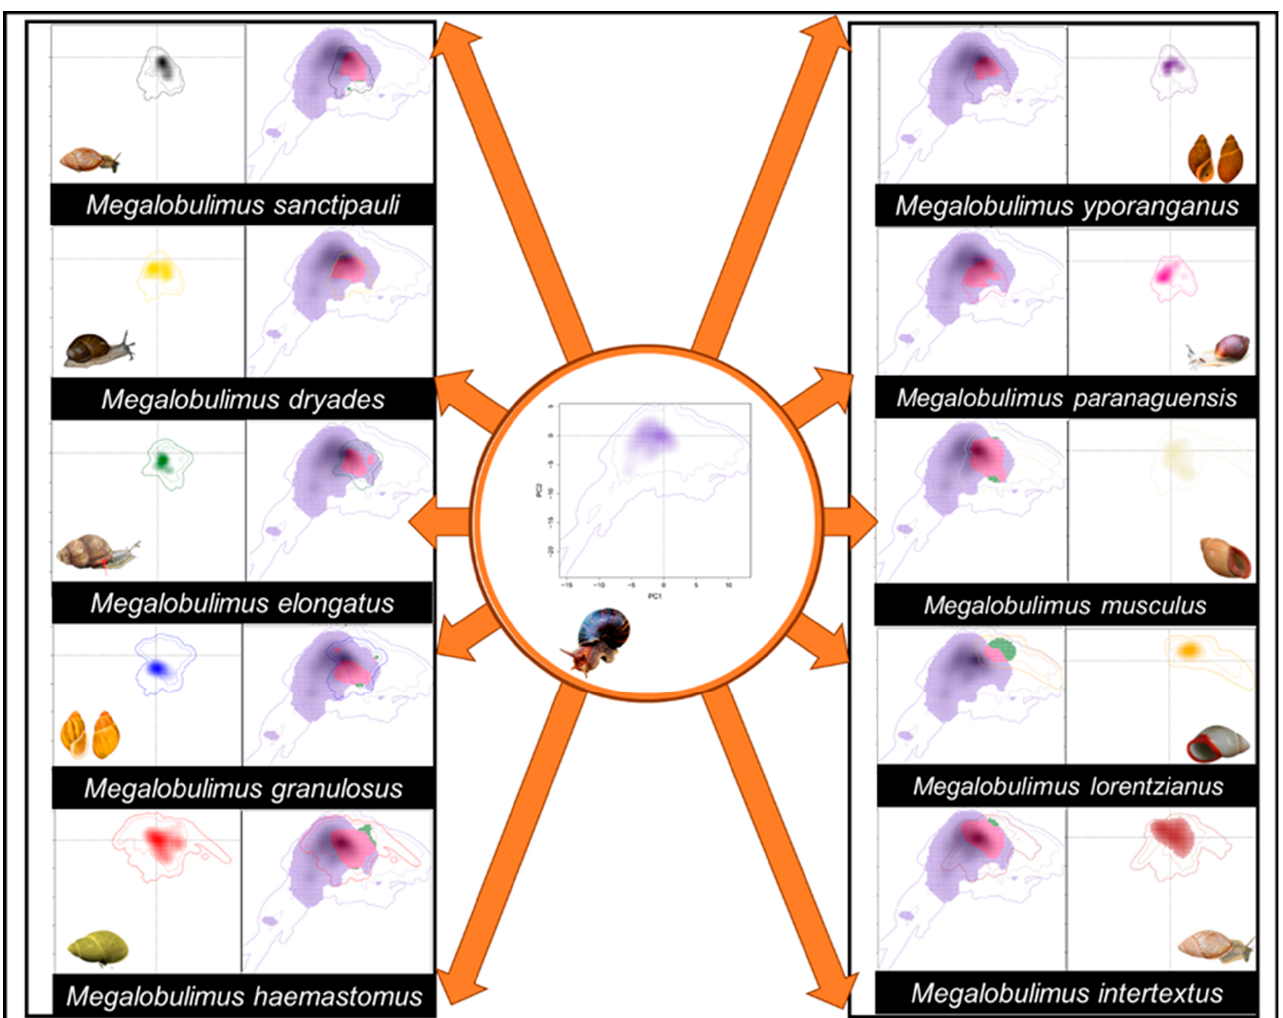
Figure 6. Broennimann et al. [38] PCA-env environmental niche analysis between Lissachatina fulica and 10 Megalobulimus species. The solid and dashed lines represent 50% and 100% of the available environmental conditions for each species, respectively. The following colors represent the species: L. fulica (purple), M. sanctipauli (black), M. dryades (yellow), M. elongatus (green), M. granulosus (blue), M. haemastomus (red), M. intertextus (brown), M. lorentzianus (orange), M. musculus (beige), M. paranaguensis (pink), and M. yporanganus (purple). In the niche overlap analysis, the stability is pink, the unfilling of Megalobulimus species in the L. fulica environmental niche is purple, and the unfilling of L. fulica in the Megalobulimus environmental niche is green. Table 3. Results of niche overlap comparison between Lissachatina fulica and Megalobulimus species. Significant p -values of the similarity test are shown in bold.